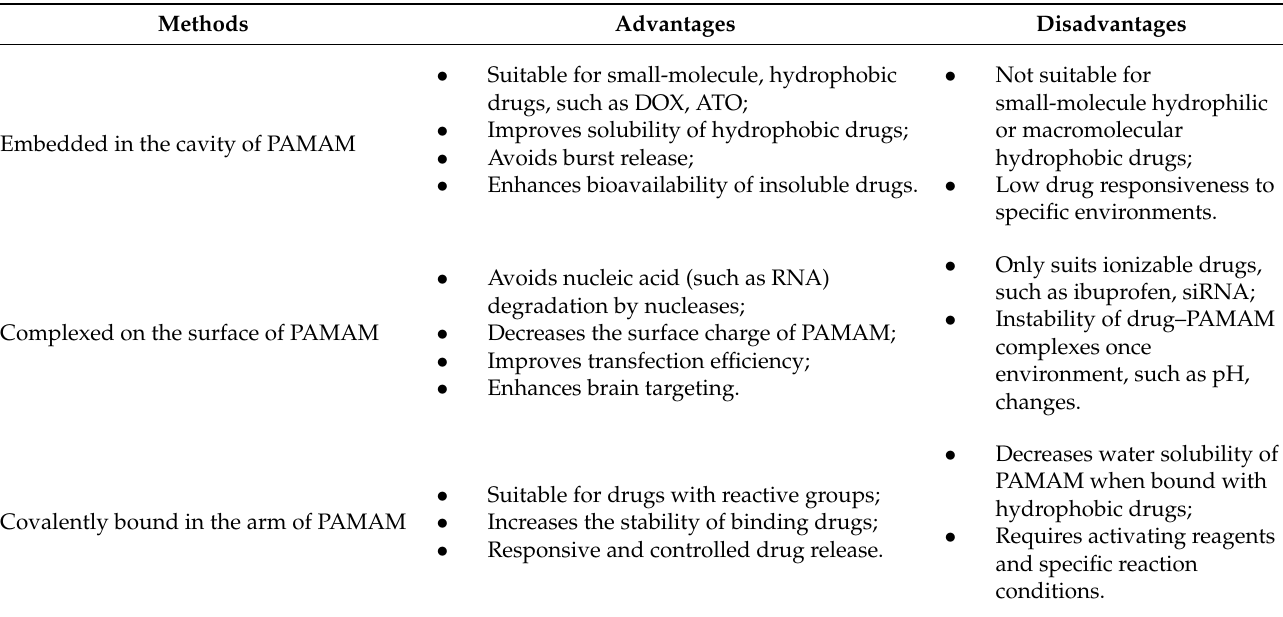
Table 1. Advantages and disadvantages of drug loading